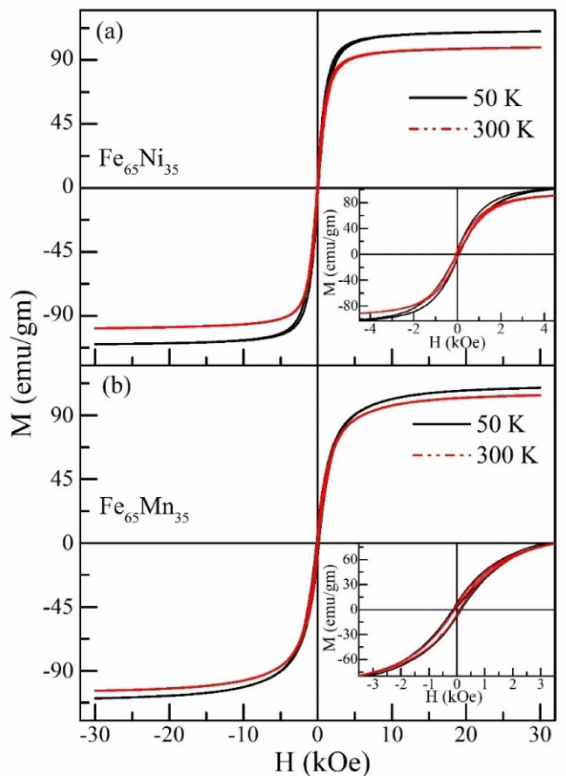
Figure 4. Applied field response of isothermal magnetization curves at 50 K and 300 K: ( a ) M − H isotherms for Fe 65 Ni 35 ; inset: M(H) curves expanded in the low-field region; ( b ) M − H isotherms for Fe 65 Mn 35 ; inset: M(H) curves expanded in the low-field